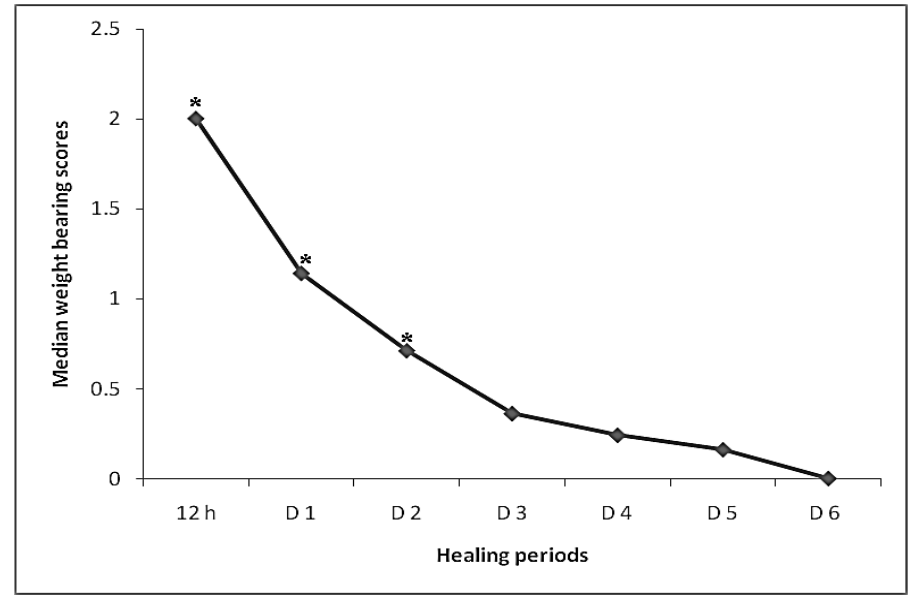
Figure 4. The line graph indicating trends of median weight bearing scores as the fracture healing progress *Denotes significant differences ( P <0.05; nonparametric Kruskal-Wallis one-way ANOVA) from D5 among median weight bearing scores at different healing intervals. (n=28) rats were evaluated for the weight bearing score from 12hrs to day 5, whereas (n=24) rats were evaluated on day 6 post surgery.